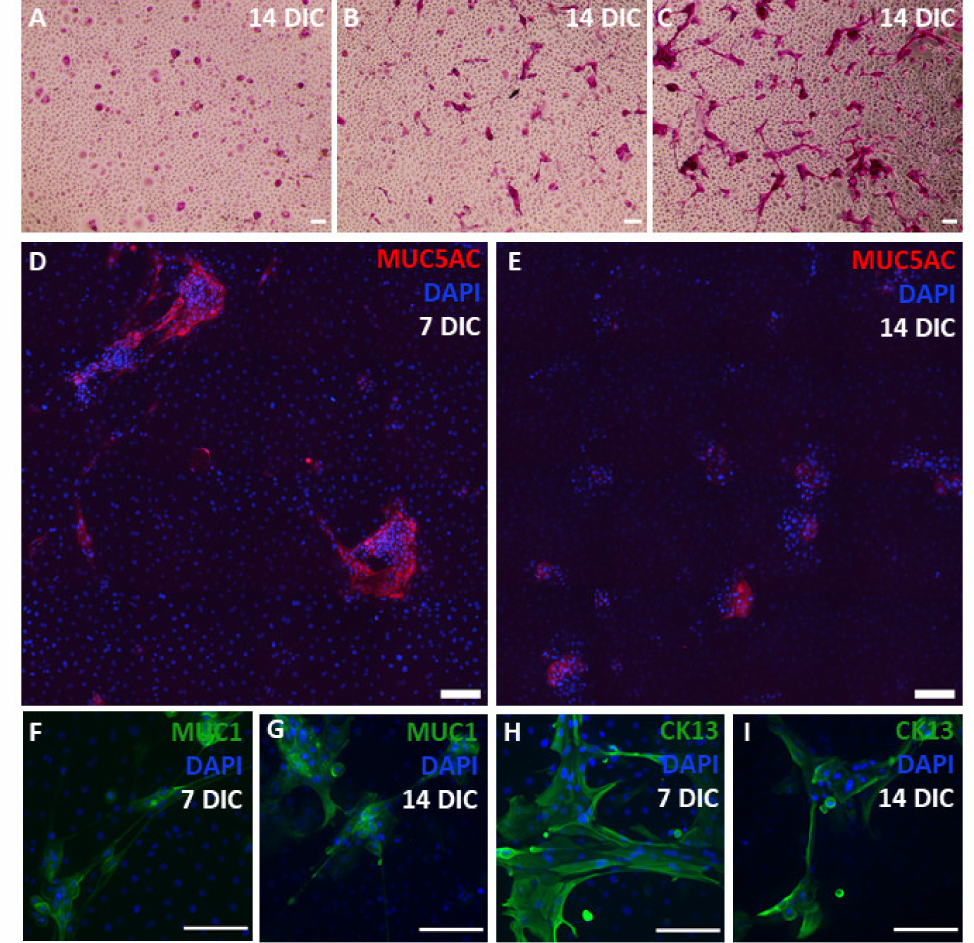
Figure 4. Morphology and organization of the goblet cells in ex vivo explant cultures. Representative images of ex vivo conjunctival explant cultures at 7 and 14 days in culture (DIC) of four different donors. Top row are PAS-stained cells ( A – C ), while the middle and bottom row show immunocyto- chemical illustrations ( D – I ). The investigated markers and corresponding colors are depicted on the images. Nuclei are counterstained using DAPI. Scale bar = 100 µ